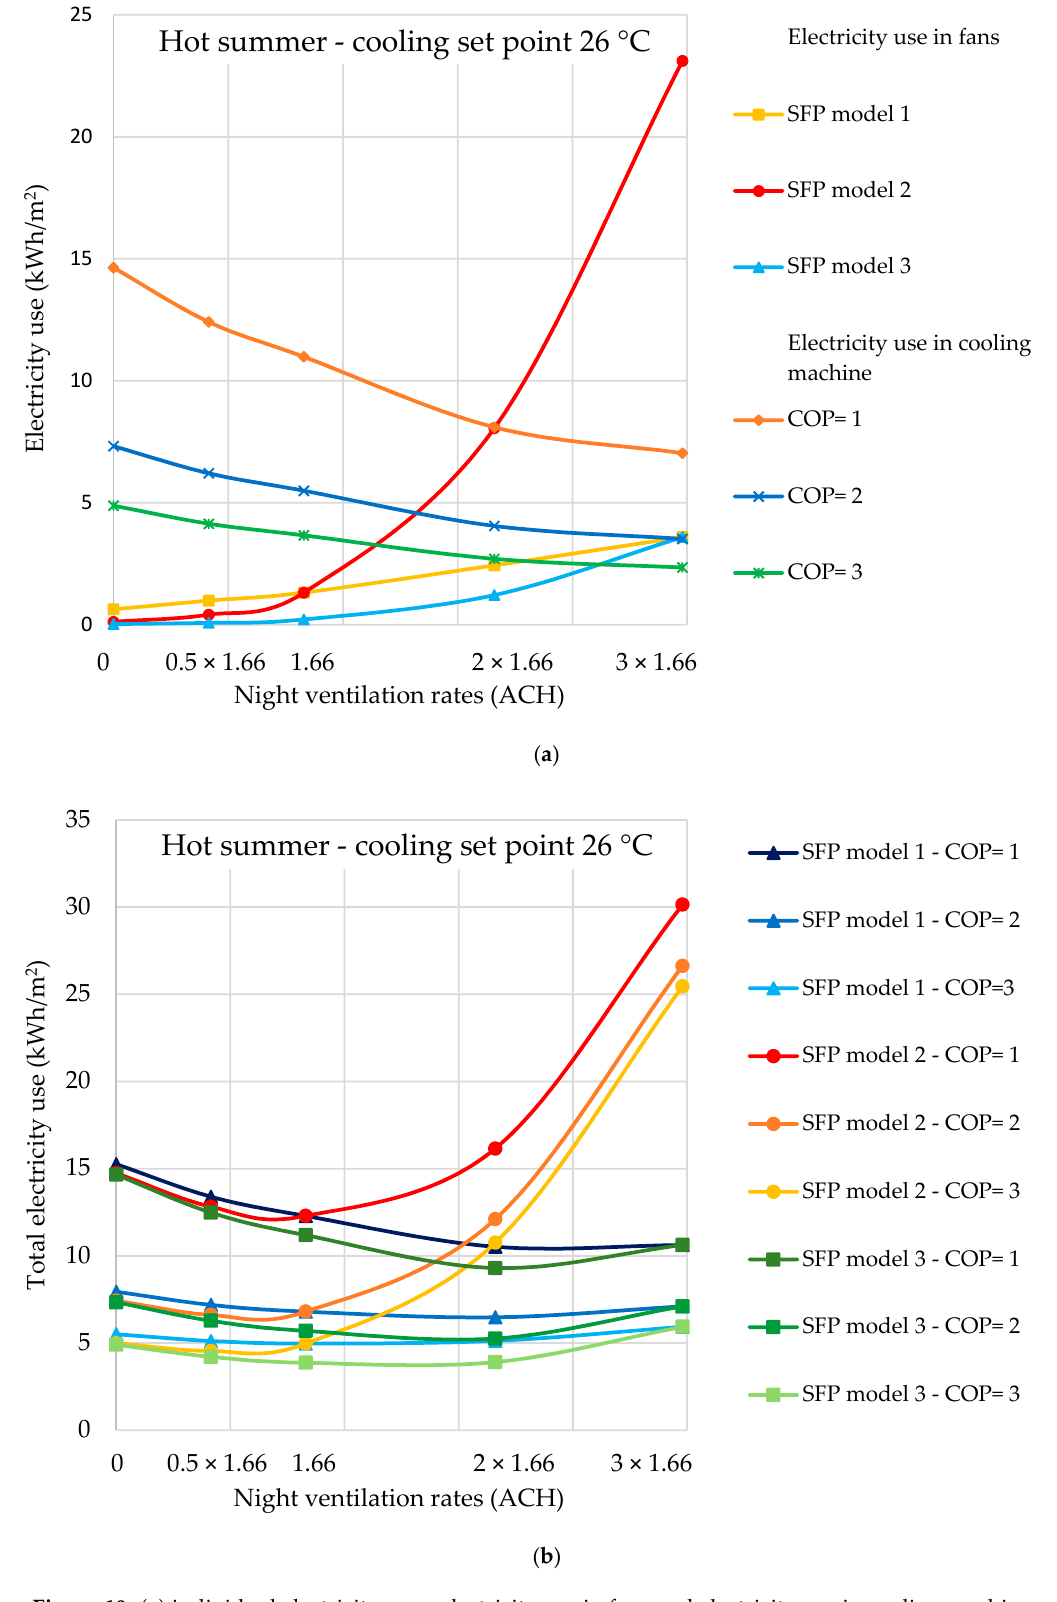
Figure 10. ( a ) individual electricity uses; electricity use in fans and electricity use in cooling machine ( b ) total electricity use for cooling (i.e., electricity use in fans + electricity use in cooling machine); during the hot summer of 2018 for operative temperature cooling set point of 26 °C.